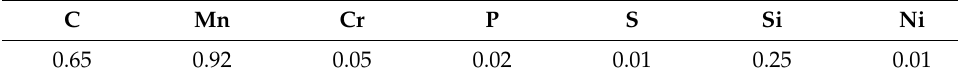
Table 1. Chemical composition (wt%) of 65Mn low-alloy